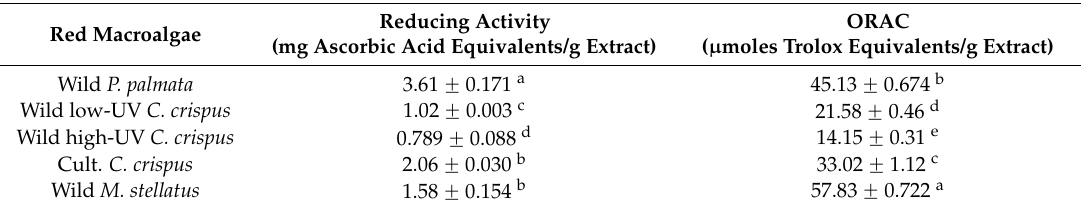
Table 2. Reducing activity and oxygen radical absorbance capacity (ORAC) of extracts from wild-harvested and cultivated red